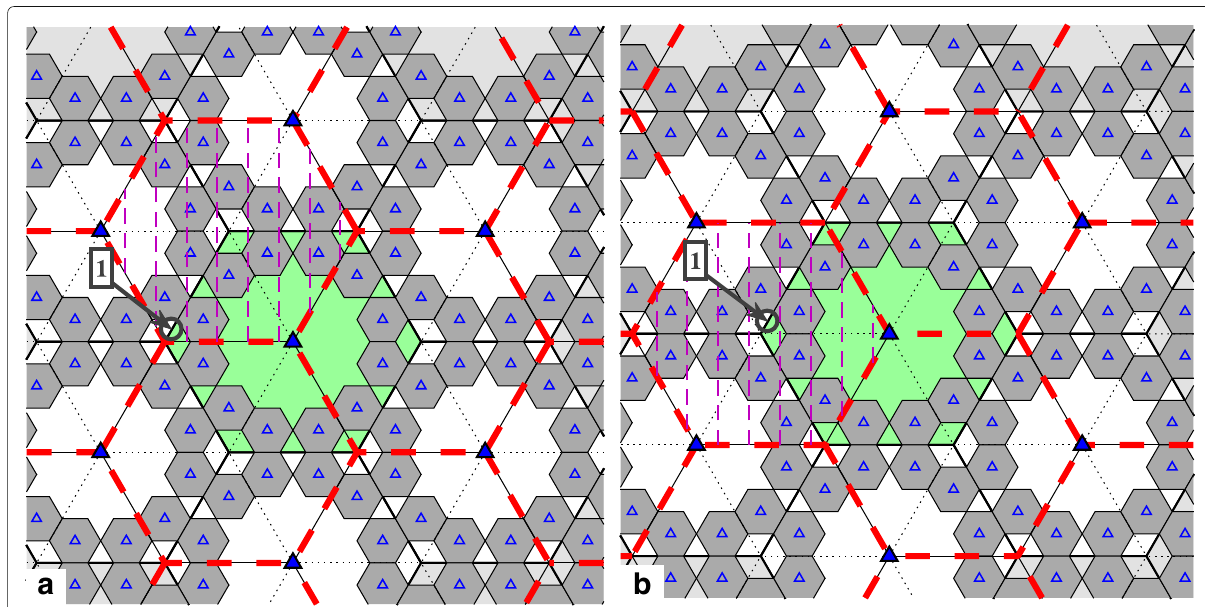
Fig. 1 Network layout with six cells per macro site for HetNet with cluster rotation: a and b depict two alternating clustering patterns of BS coordination. Solid and open triangles represent macro BS sites and pico BSs, respectively, and the thick red dashed hexagons denote